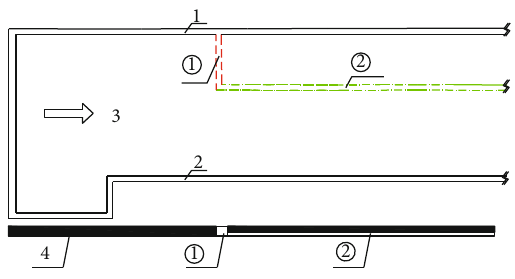
Figure 1: The distribution of abandoned roadway in the workingface. ① and ② — abandoned roadway; 1 — haulage roadway; 2 — ventilation roadway; 3 — 30106 working face; 4 — coal.